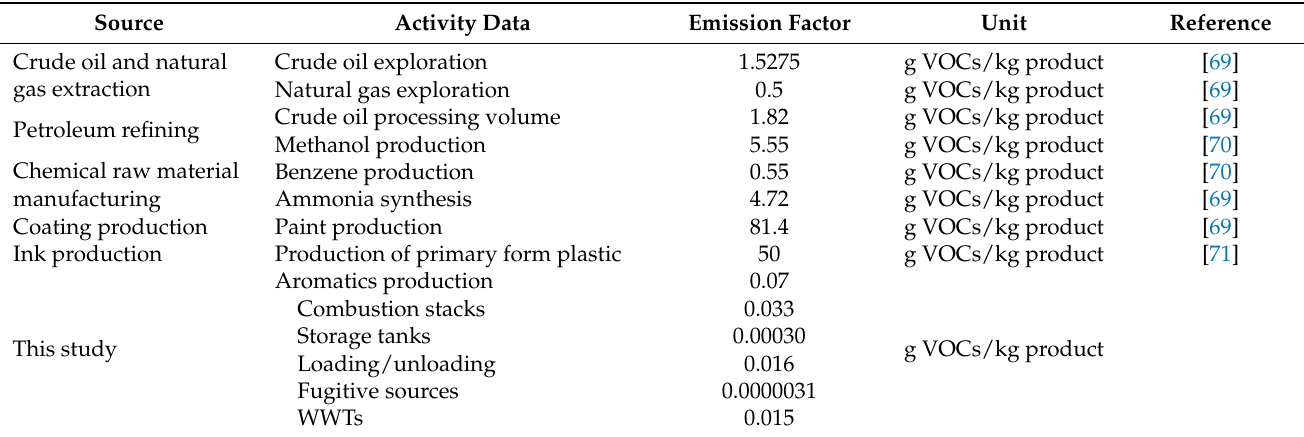
Table 4. Comparison of emission factors with other